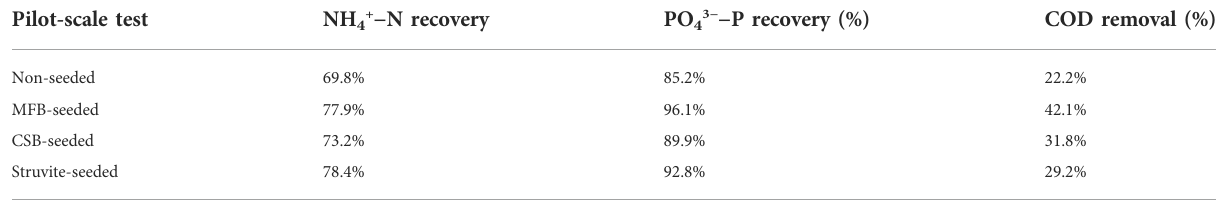
TABLE 3 Performance of the pilot-scale test during non-seeded, MFB-seeded, CSB-seeded, and struvite-seeded processes. Pilot-scale